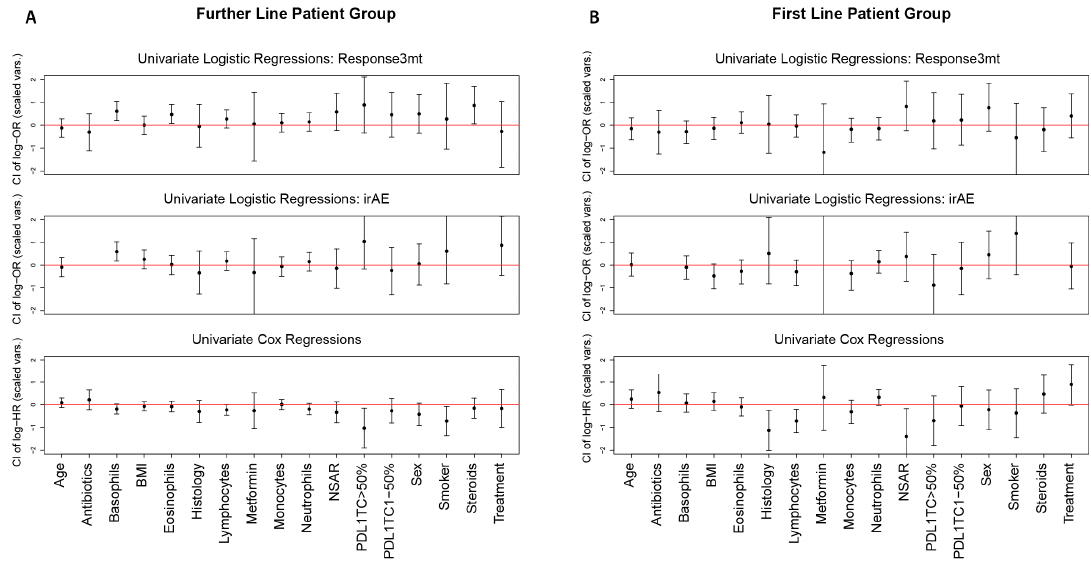
Figure 2. Estimated log-OR (log-HR) and 95% CI for each univariate logistic (Cox) regression using standardized predictors for ( A ) the further-line patient group and ( B ) the first-line patient group.